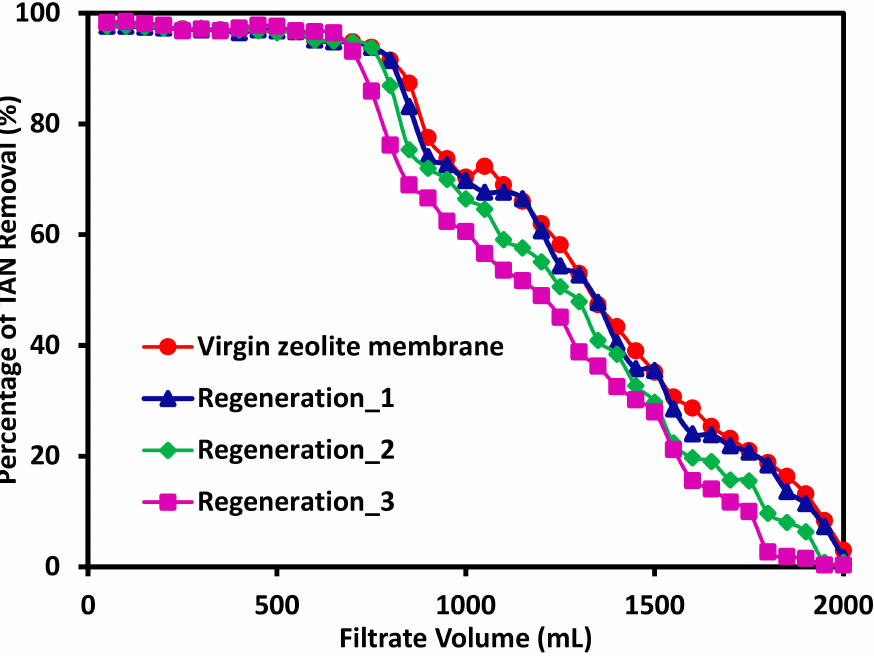
Figure 6. The TAN removal rates as a function of feed volume with the fabricated 20%PES- 100%Zeolite13X mixed-matrix membranes over multiple removal and regeneration